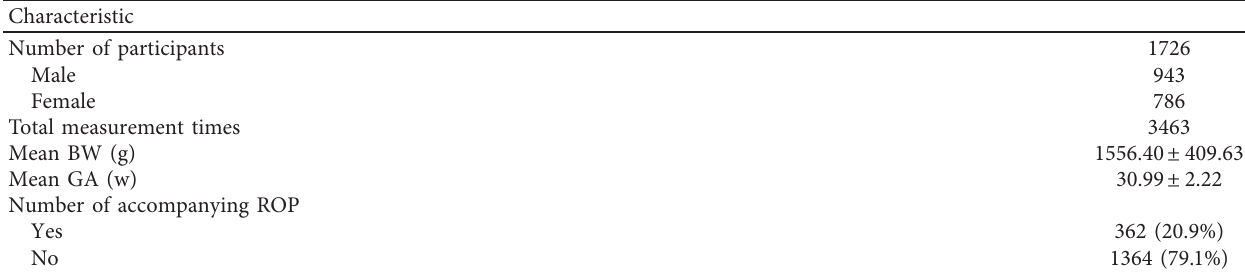
Table 1: Baseline characteristics of premature infants.